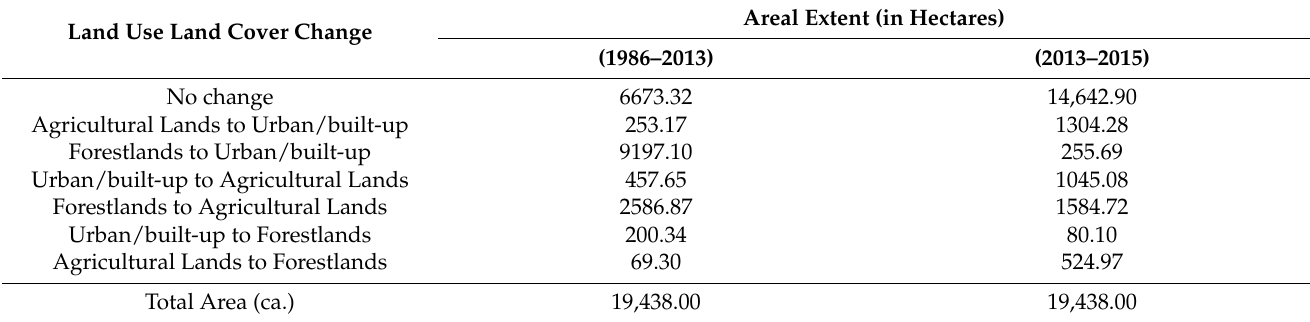
Table 5. Change analysis of the area of change from 1986 to 2015.